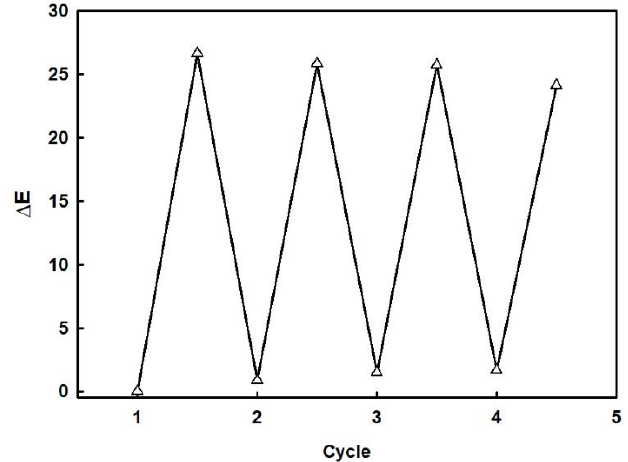
Figure 6. Acidic gas detection cycle of dyed textile sensor.